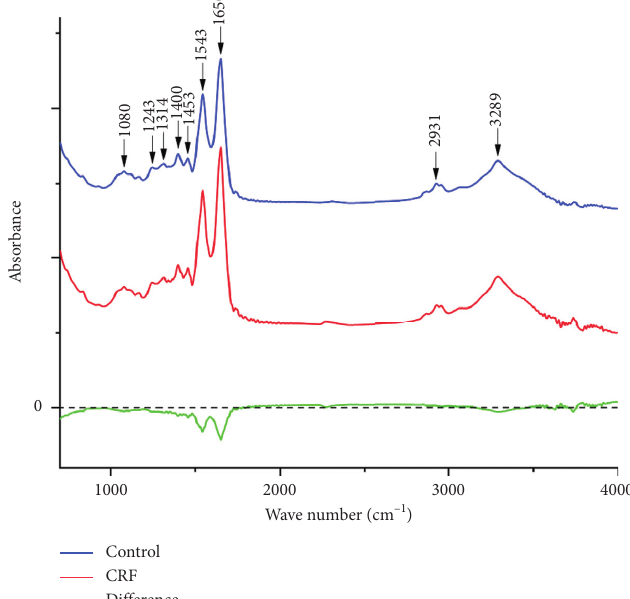
Figure 1: Comparison of the normalized mean FT-IR spectra between patients with CRF and individuals with normal renal function.